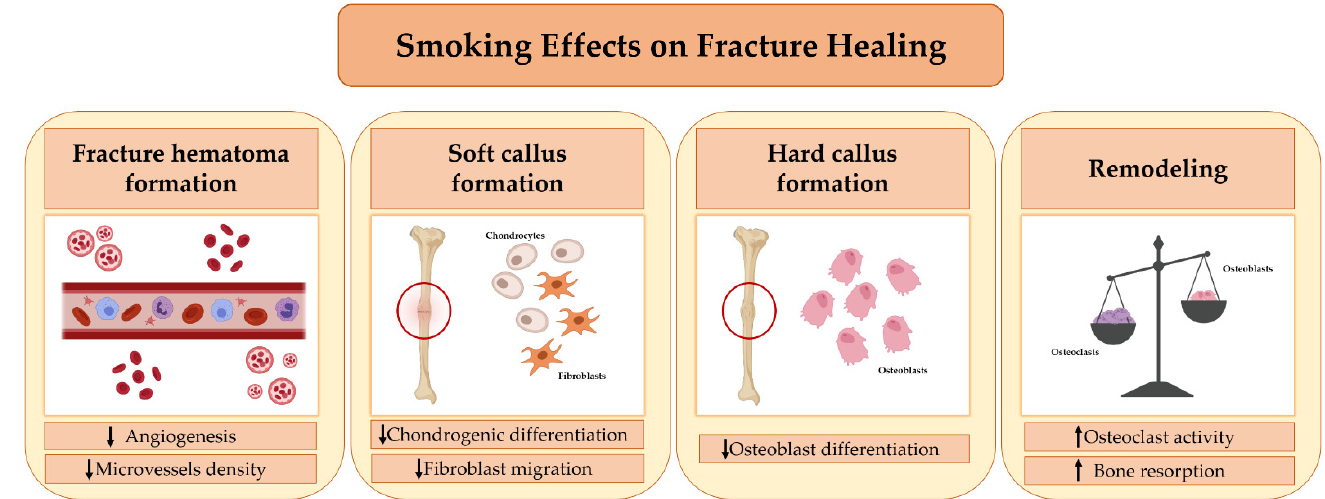
Figure 1. Smoking’s effects on Fracture Healing. Cigarette smoking affects every stage of fracture healing. First, it alters the formation of the fracture hematoma, impairing the process of angiogenesis. Second, it adversely affects the migration, proliferation, and differentiation of mesenchymal stem cells (MSCs) into chondrocytes, fibroblasts, and osteoblasts, impairing soft callus formation and the subsequent transition into a hard callus. Finally, smoking causes an imbalance between the activity of osteoblasts and osteoclasts, promoting the process of bone resorption and leading to a delay in fracture healing.